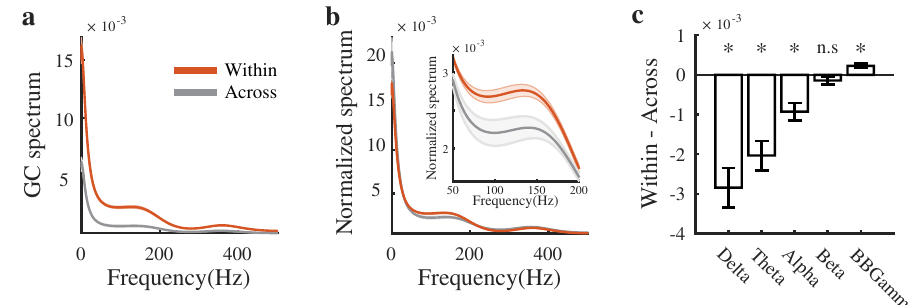
Fig.3|Within-vsacross-modulecommunication.a AveragerawGrangerspectra for an individual MEA. b Normalizing the Granger causality spectra to have area 1 allowsforthecomparisonofwithin-vsacross-moduleconnectivityasafunctionof frequency. c Difference in GC as a function of frequency band across all MEAs.